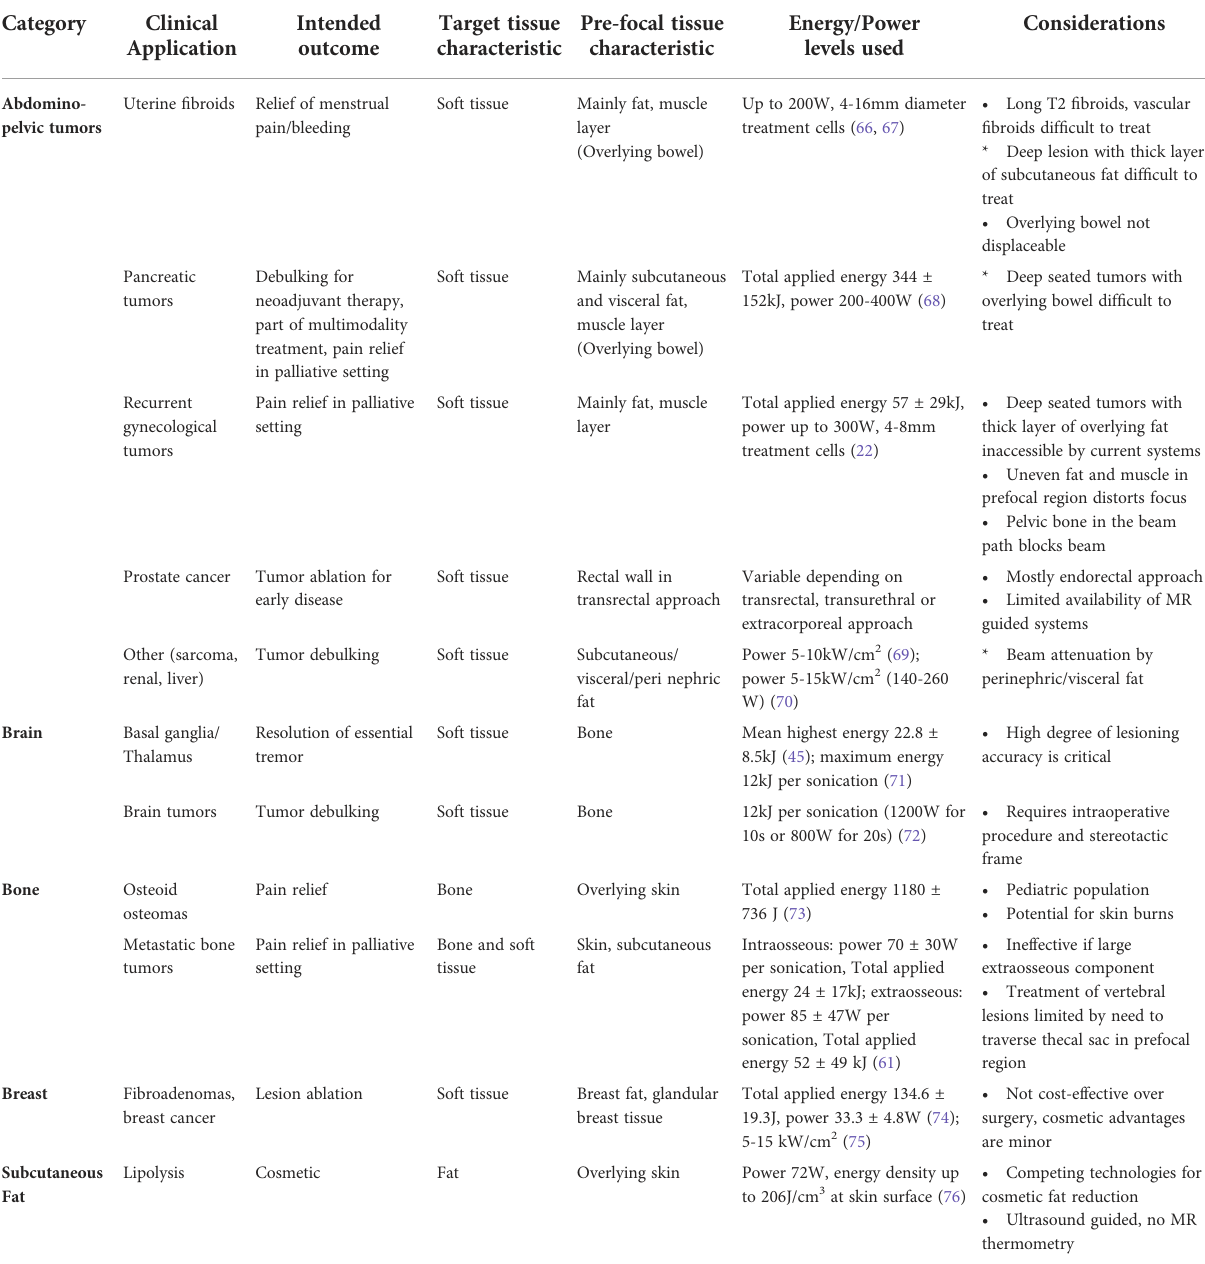
TABLE 1 Categories, clinical need and tissue characteristics of lesions treated with HIFU.